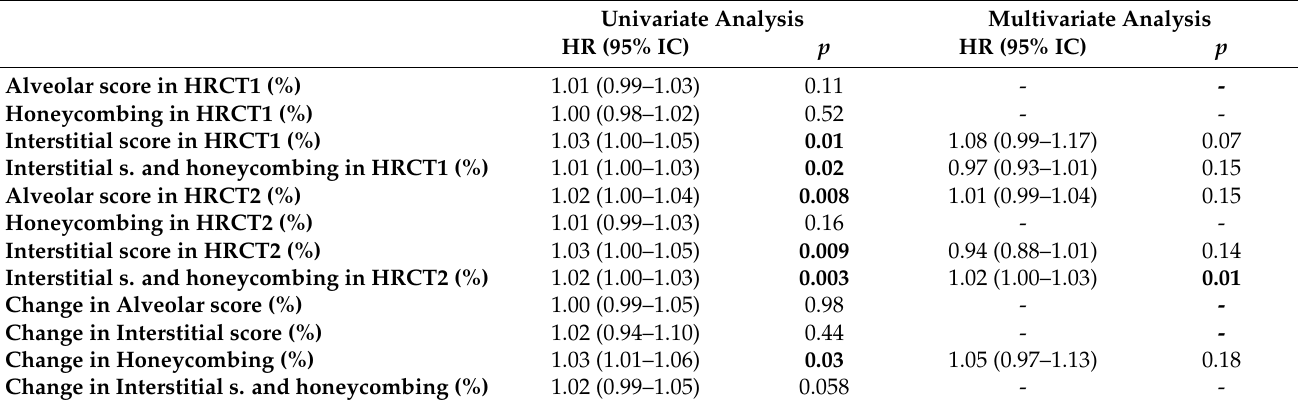
Table 2. Predictive factors of overall mortality in the entire population of IPF patients treated with antifibrotics.